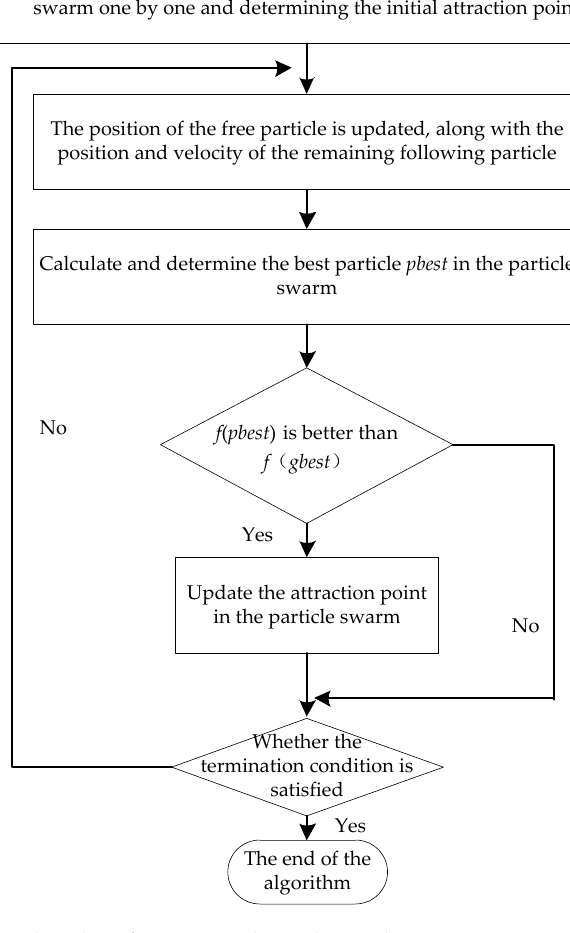
Figure 3. Flowchart for improved social particle swarm optimization (SPSO).